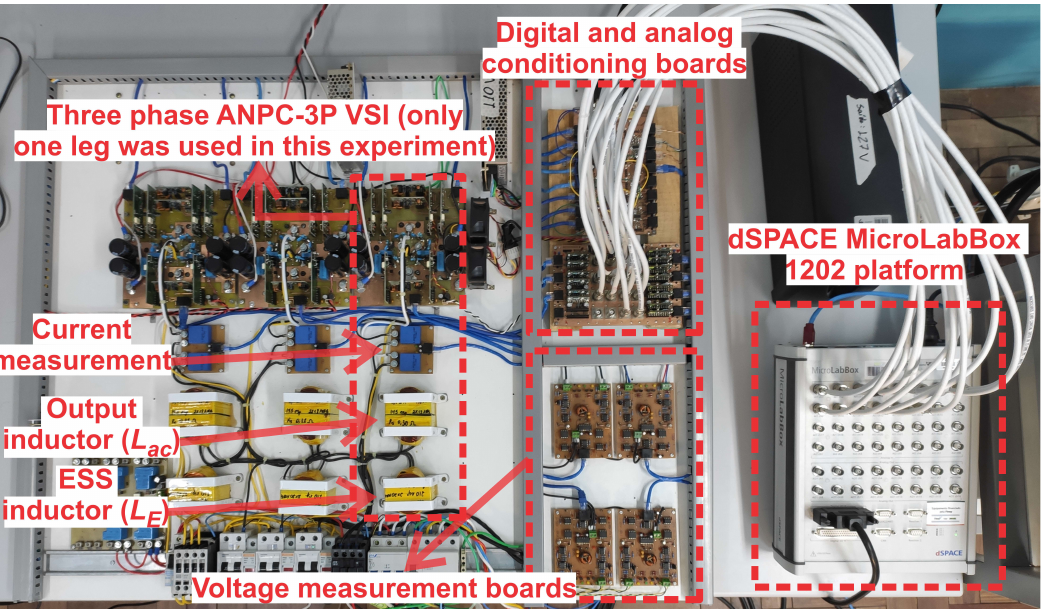
Figure 9. Picture of the experimental